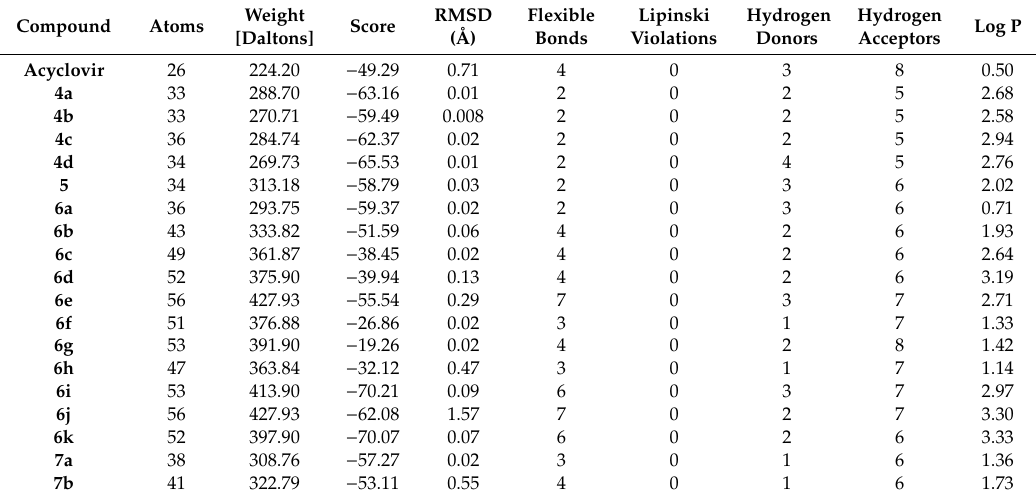
Table 1. Docking score and calculated properties of ligands.